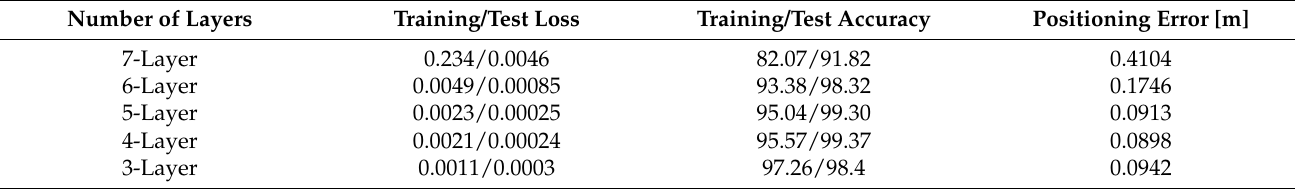
Table 3. Performance analysis for various numbers of